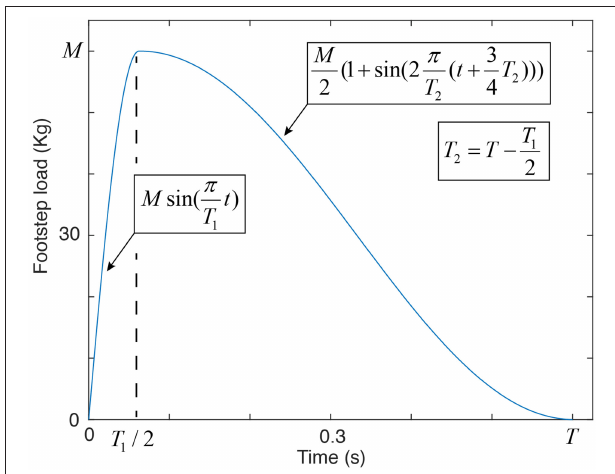
FIGURE 6 | The footstep-impact load function is conceptualized as a succession of two sine functions. M describes the weight of a person. The first period T 1 defines the contact phase, during which, the full weight is applied to the ground. The second period T 2 is related to the toe-off of the foot.